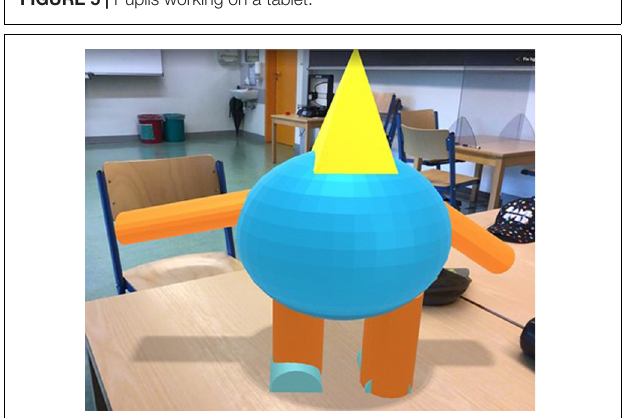
FIGURE 5 | Pupils working on a tablet.